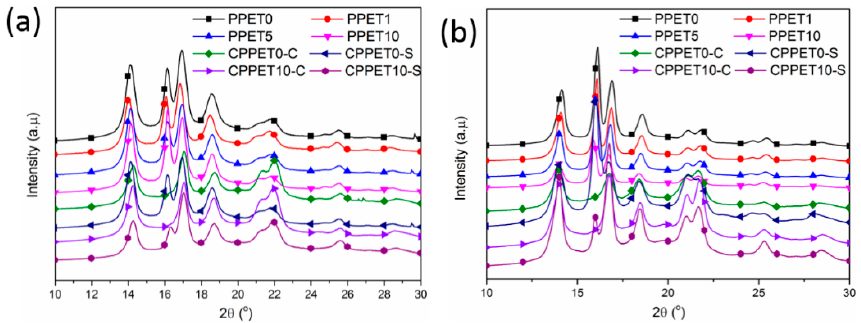
Figure 12. DSC melting curves of the samples: ( a ) T mold = 80 °C; ( b ) T mold = 120 °C; C represents the core layer; S represents the skin layer.